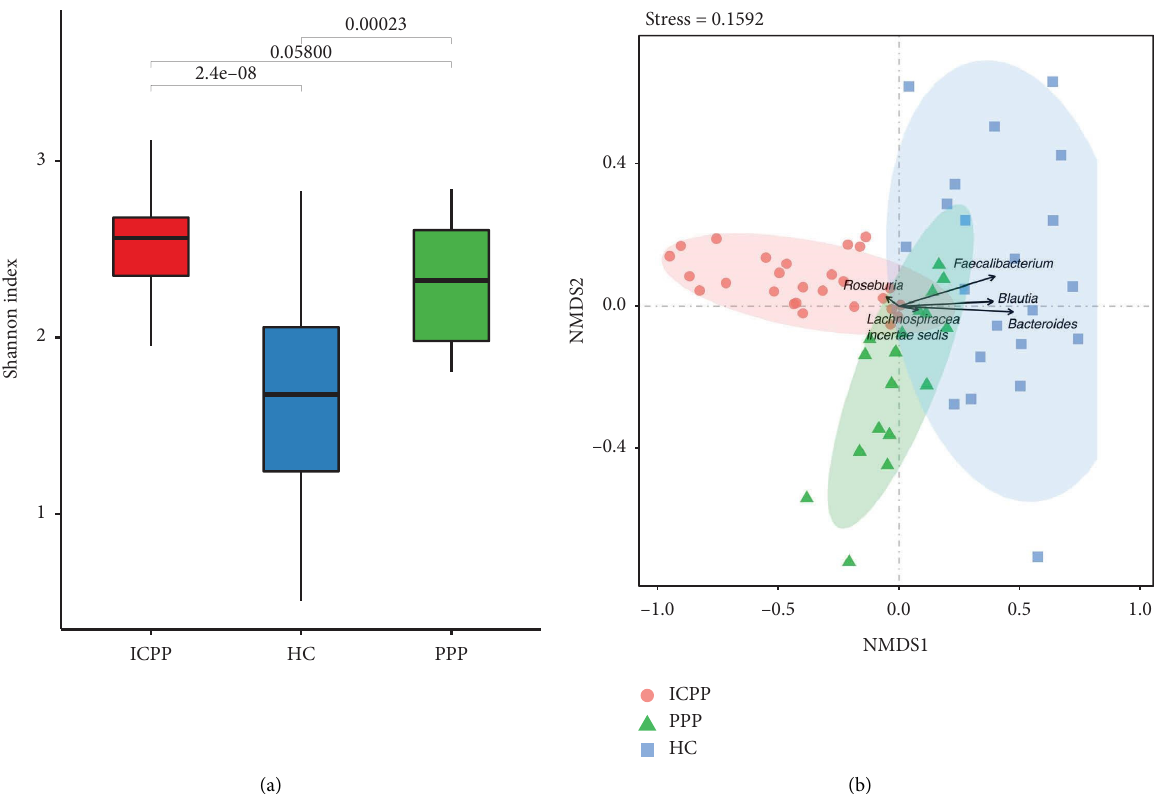
Figure 1: Te microbiota diversity of the fecal samples from the PPP, ICPP, and HC groups. (a) Te α -diversity of GM from the PPP, ICPP, and HC groups was shown by the Shannon index. (b) Te NMDS analysis of all the samples from three groups and presented by red circle (ICPP), green triangle (PPP), and blue cube (HC).